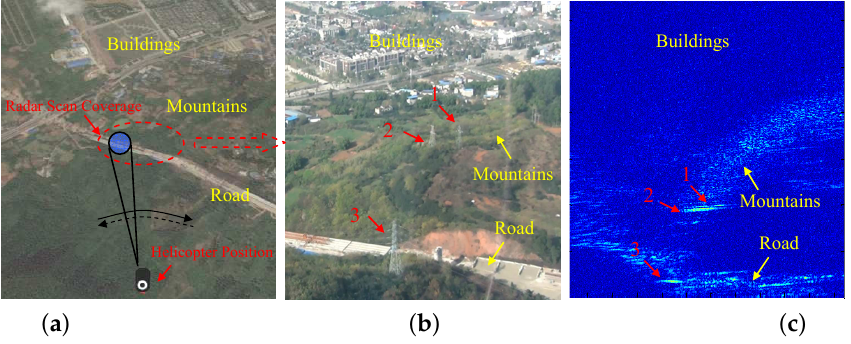
Figure 15. Data collection scene: ( a ) Latitude and longitude information of the low-flying helicopter corresponding to the chosen target scene marked on Google Maps; ( b ) Optical image corresponding to the radar scan coverage; ( c ) Corresponding radar data